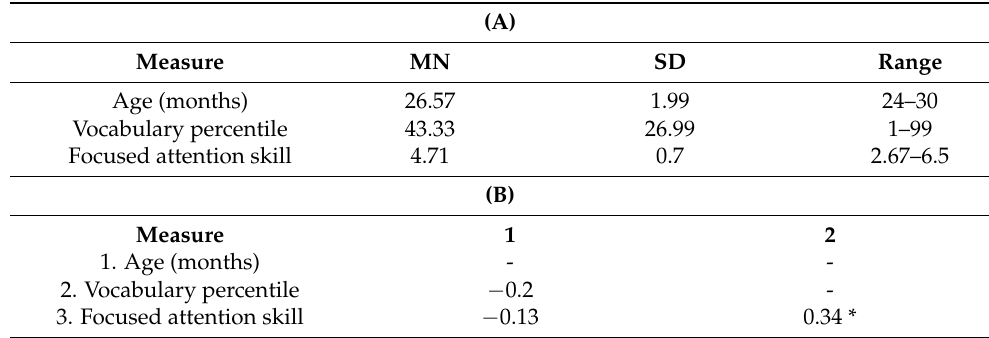
Table 1. (A) Descriptive statistics for age, vocabulary percentile, and focused attention skill. ( B ) Pairwise correlations for age, vocabulary percentile, and focused attention